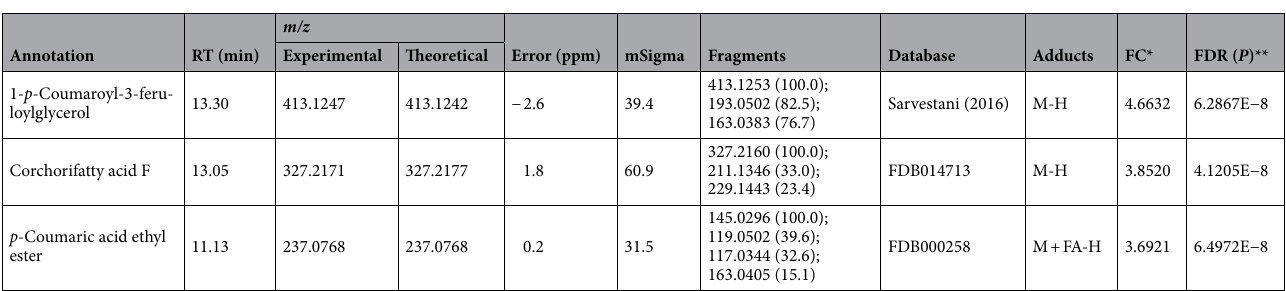
Table 2. Metabolites detected by LC–MS/MS analyses whose content was differentially accumulated between South American rice water weevil ( Oryzophagus oryzae )-resistant and susceptible rice cultivars [ P ≤ 0.05 and Fold Change (FC) ≥ 2.0]. *A positive FC-value means the feature was increased in the resistant (‘Dawn’) relative to the susceptible (‘BRS Pampa CL’) group. **FDR-adjusted P value according to Student’s t